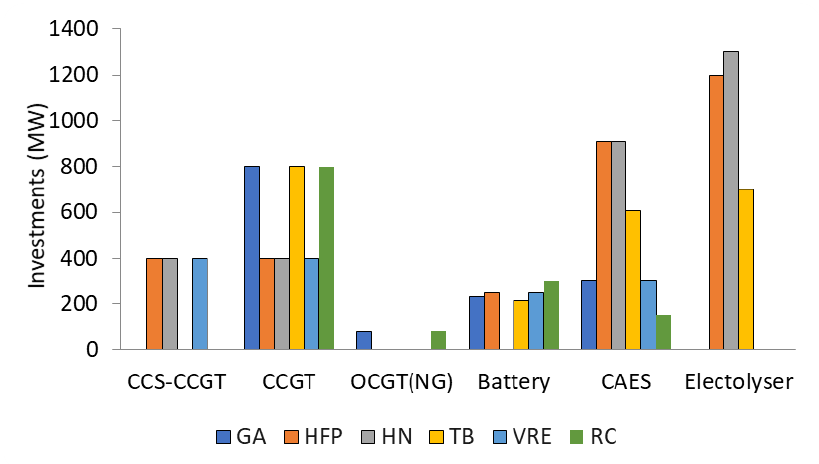
Figure 3. 2030 investments including dispatchable generation capacities and load (electrolysers). OCGT(NG) refers to natural gas powered